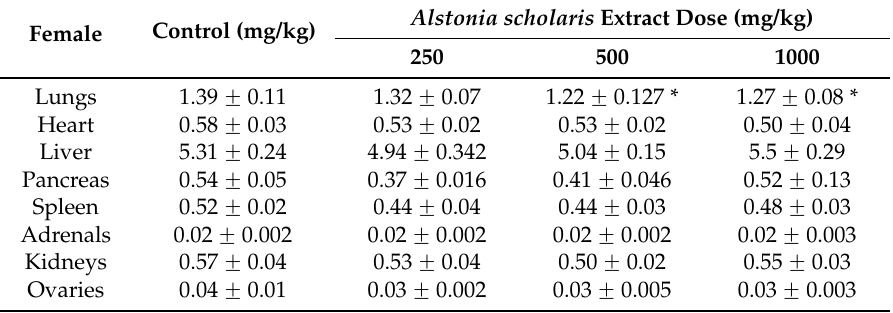
Table 1. Organ weights (g) of the female rats in the sub-acute toxicity study of the methanolic extract of Alstonia scholaris . Results were expressed as the mean ˘ S.E.M. of 5